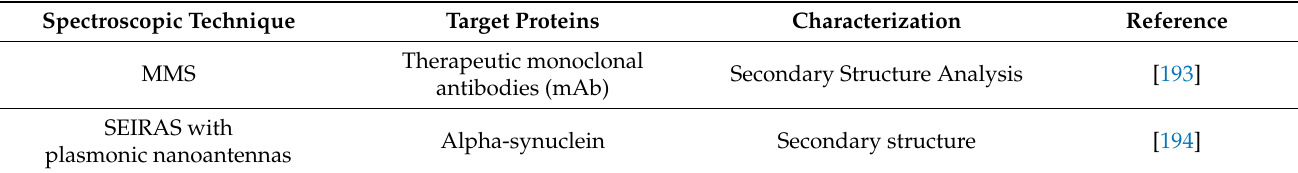
Table 4. Applications of IR spectroscopy in microfluidic devices for investigation of